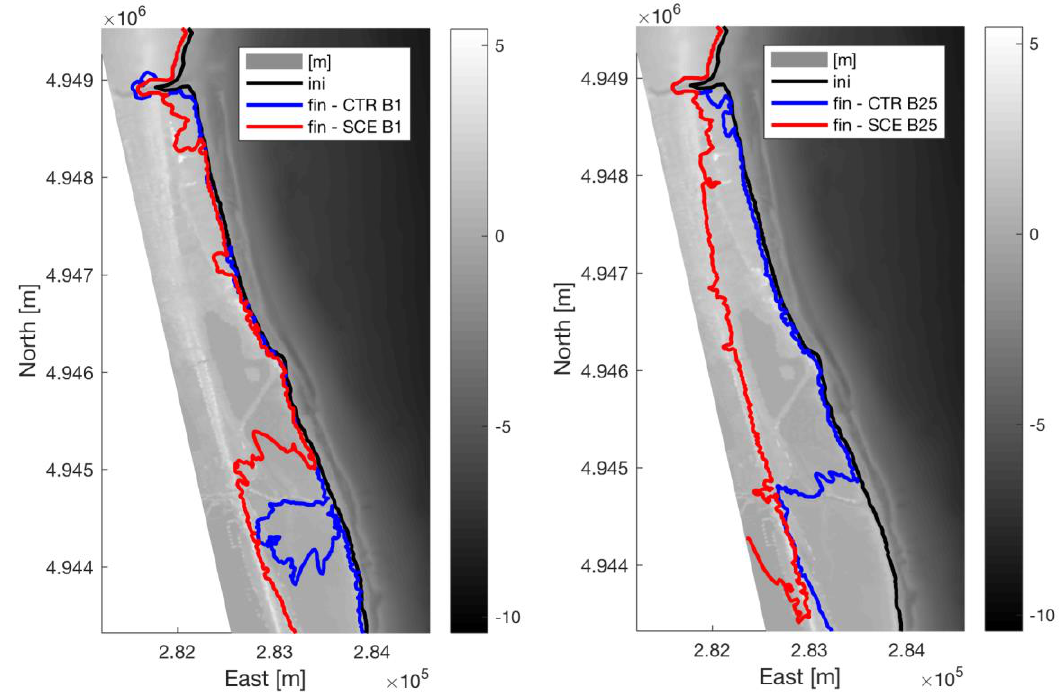
Figure 14. Bora events. Inundated areas for ordinary ( left panel ) and extreme ( right panel ) events and for CTR (blue lines) and SCE (red lines) scenarios. Black lines indicate the initial shoreline.